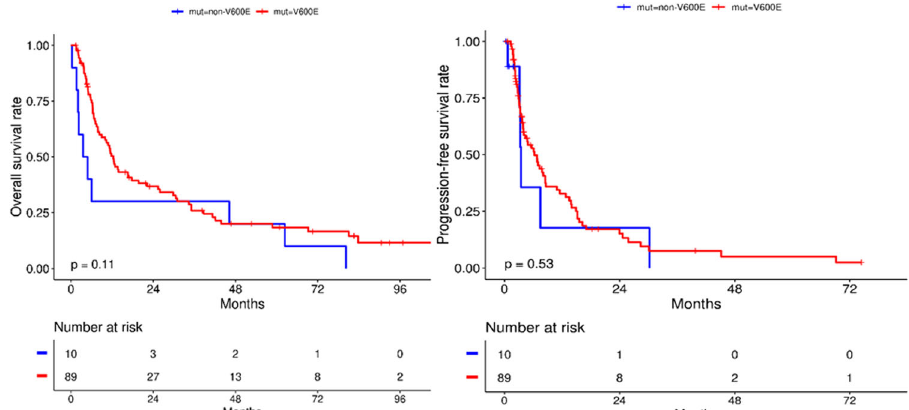
Fig. 3 Survival outcomes based on prior BRAF therapy exposure. The median OS (12.6 months) was statistically signi fi cant in the BRAF therapy naïve group compared to the BRAF therapy refractory group (10.4 months) ( P = 0.024). The median PFS was also statistically